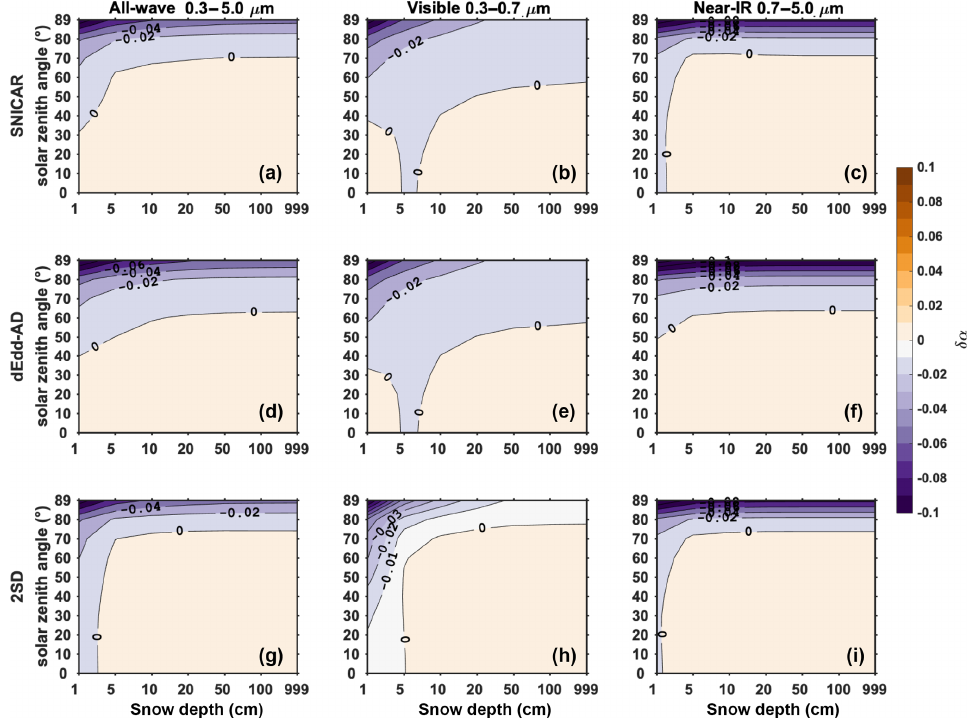
Figure 4. The difference in direct snow albedo ( δα = α 2 − α 16 ) computed using two-stream models ( α 2 ) and using the 16-stream DISORT model ( α 16 ), for various snow depths and solar zenith angles, with a snow grain radius of 1000µm.